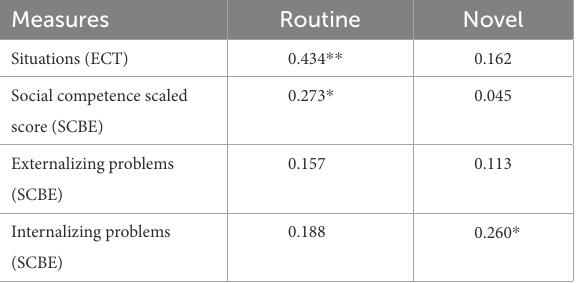
TABLE 3 Correlations between ARC subscales, CBQ subscales, and